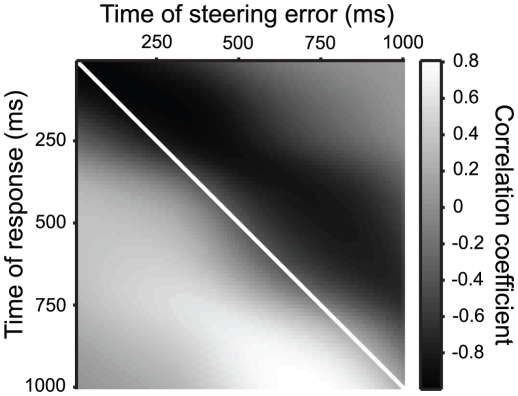
Correlation matrix for monkey F, step amplitude −10 deg.The gray level value in each pixel represents the correlation coefficient between the steering error at one moment in time, θ(t), and the steering response at another moment in time, r(t'). The solid white line shows where t = t'.